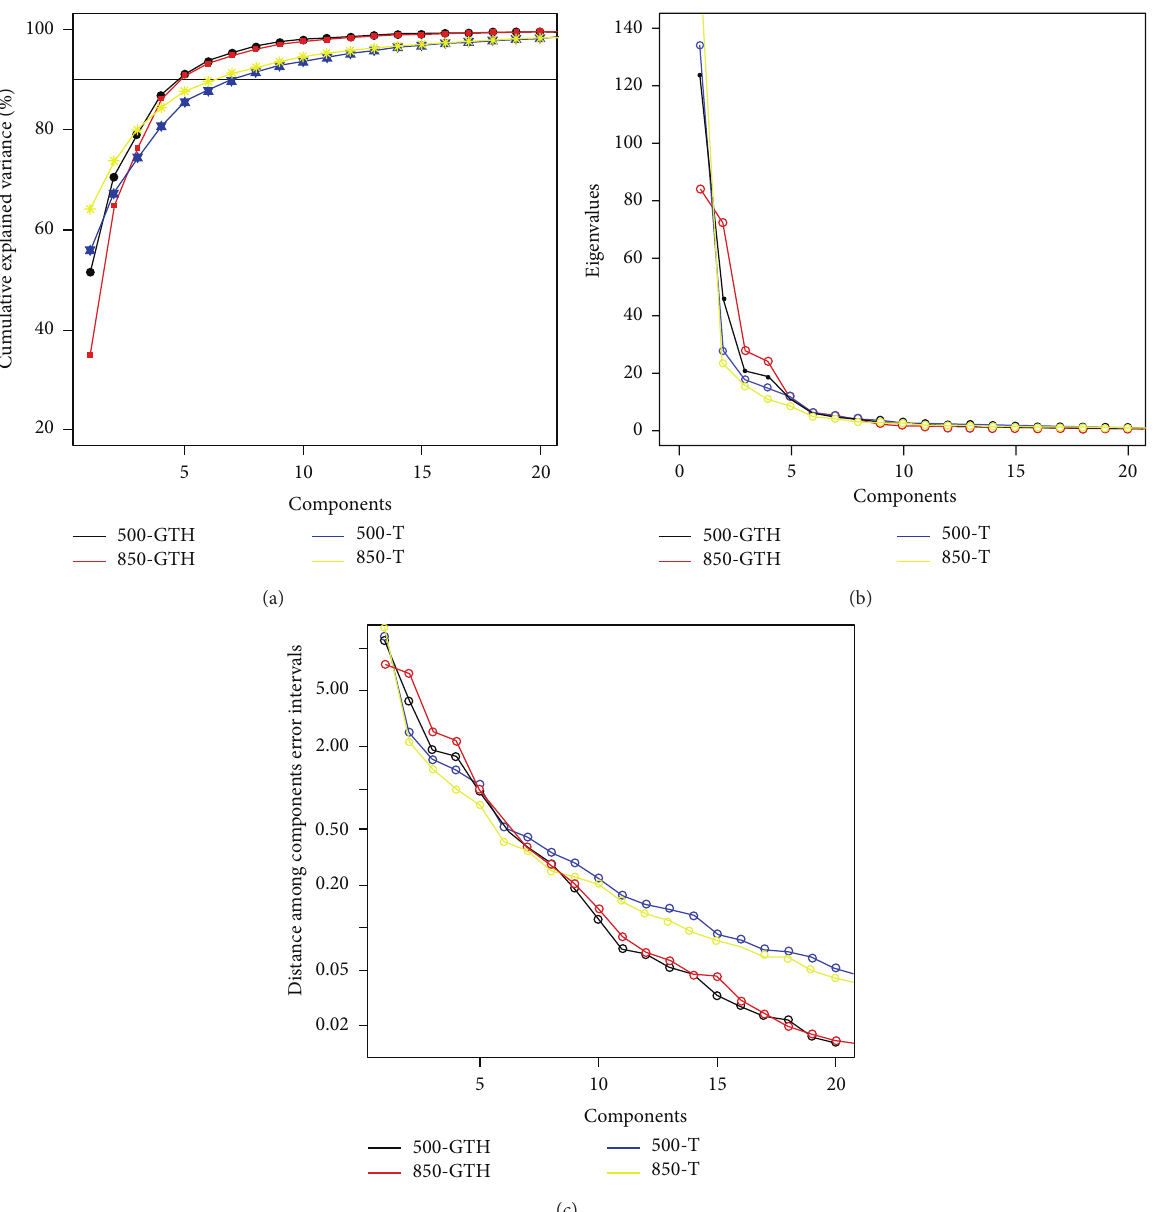
Figure 4: PCA applied to each variable. (a) Cumulative explained variance (%); black horizontal line indicates cumulative variance 90%. (b) Scree test. (c) North rule of